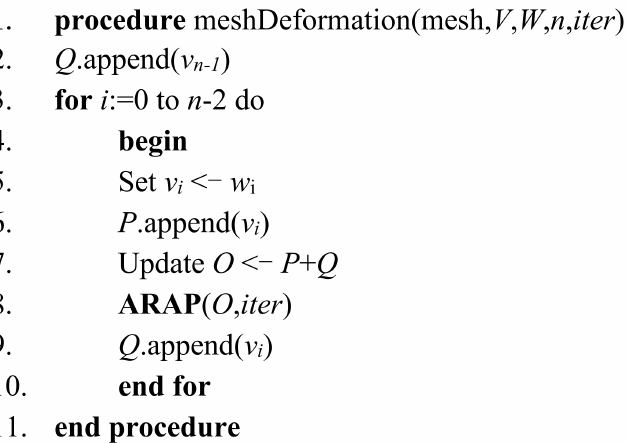
Figure 6. Pseudocode of vein-driven leaf mesh deformation. The keywords and function names are in bold in